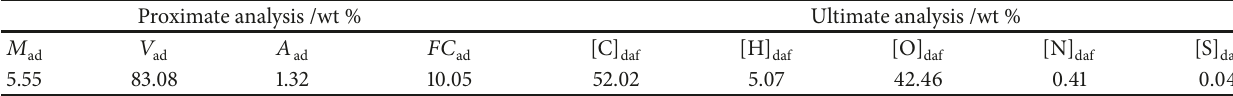
Table 1: Proximate and ultimate analysis of biomass granular